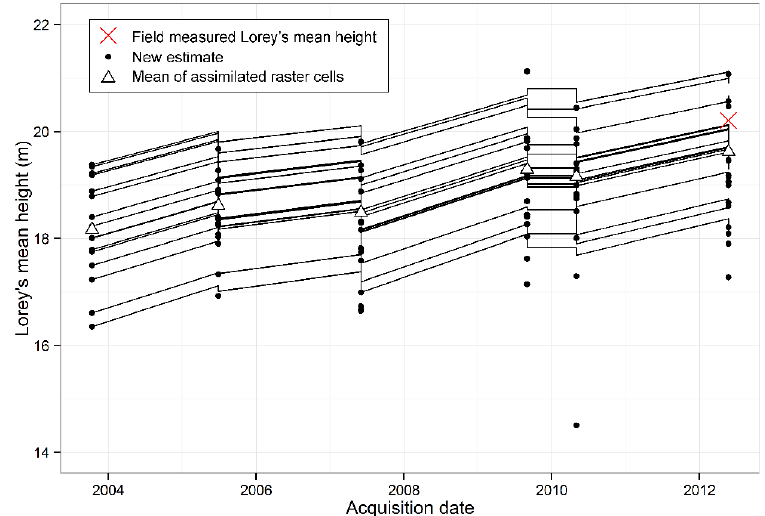
Figure 6. Data assimilation of Lorey’s mean height on validation plot 212. The black dots are the estimates from remote sensing where each dot represents one 18 m × 18 m raster cell within the validation plot. The triangles are the mean value of the assimilation for each time-point. The red cross is the field measured Lorey’s mean height for the same growth season (2011) as the last acquisition. The black lines are the current estimate for each raster cell. Note that the lines jump either up or down depending on the outcome of the assimilation at each acquisition time-point.